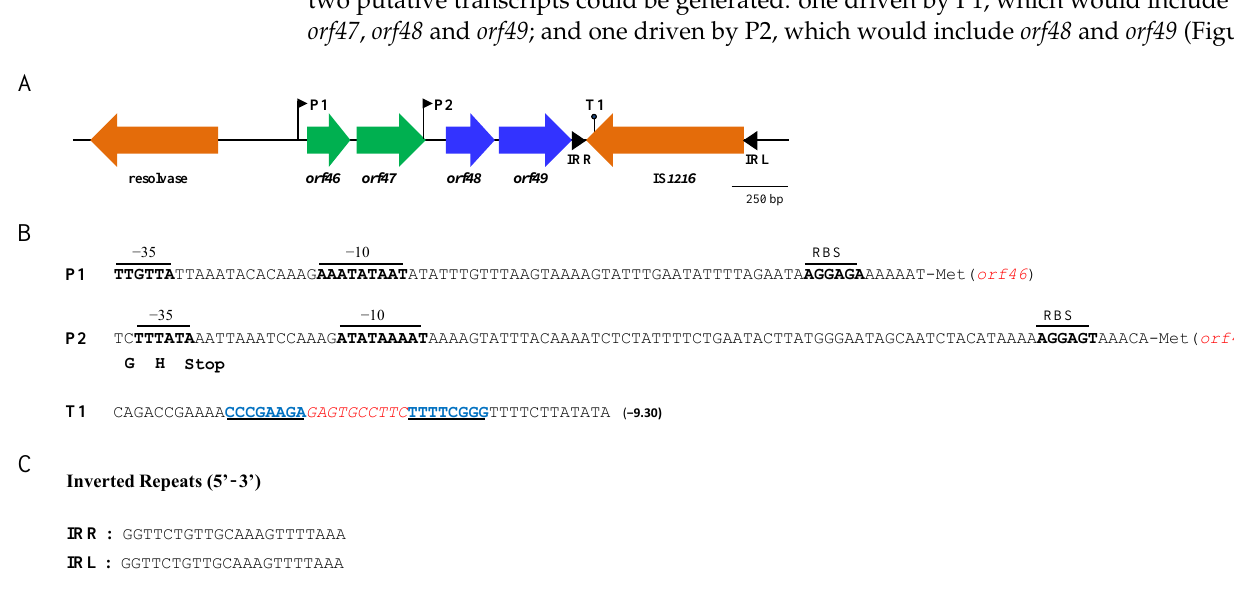
Figure 2. Schematic representation of a 3.1-kpb DNA fragment from plasmid pLG50 of L. garvieae Lg-Granada that contains the genes encoding garvicins AG1 ( orf46 ) and AG2 ( orf48 ) and their corresponding immunity proteins, orf47 and orf49 , respectively ( A ); detailed analysis of predicted promoters and Rho-independent terminator ( B ); and inverted repeats sequences of the IS1216 transposase ( C ). ( A ) P1 and P2 are putative promoter sequences, whereas T1 is a putative Rho-independent transcription terminator. IRR and IRL correspond to the right and left inverted repeat sequences flanking the transposase of IS1216, respectively. Resolvase indicates the orf encoding a putative transposon gamma – delta resolvase gene. ( B ) The putative promoters P1 and P2 were detected with Softberry BProm. The typical − 35 and − 10 boxes and the ribosome binding sites (RBS) are shown; “Met” in the P1 and P2 sequences indicates the methionine residues of GarAG1 and AG2, respectively. “Stop” in the P2 sequence indicates the termination codon of orf46 . ARNold was used to predict the Rho-independent terminator (T1); base pairs of the hairpin are shown in blue boldface, and apical loops are indicated by red italics. The predicted free energy of terminator hairpins (kcal/mol) is given in parentheses. ( C ) The 22 bp right and left inverted repeats (IRR and IRL, respectively) of IS1216 showed 100% identity in their nucleotide sequence.